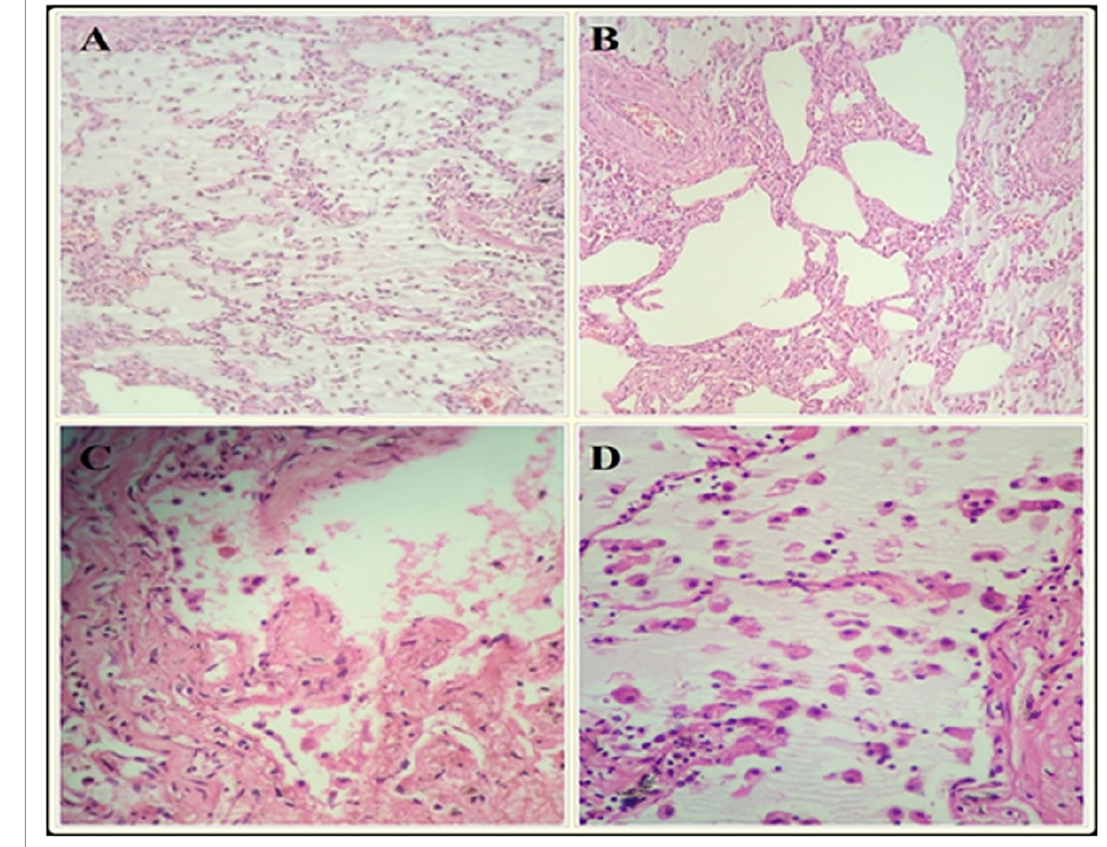
Figure 3: Early phase histological changes of COVID-19 pneumonia. ( A) Alveolar oedema, intra-alveolar fibrin, pronounced protein and fibrin exudates. (B) Diffuse expansion in the alveolar wall containing proliferated interstitial fibroblasts and type II pneumocytes. (C) Focal fibroblast plugs in the interstitium. (D) Alveolar macrophage, multi-nucleated cells, prominent lymphocyte infiltrate and type II pneumocyte